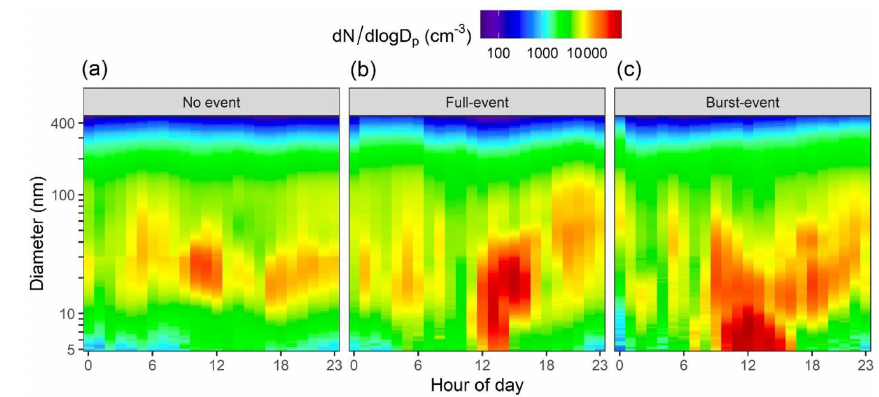
Figure 1. Average SMPS contour plots for (a) non-event days, (b) full-event days and (c) burst-event days.